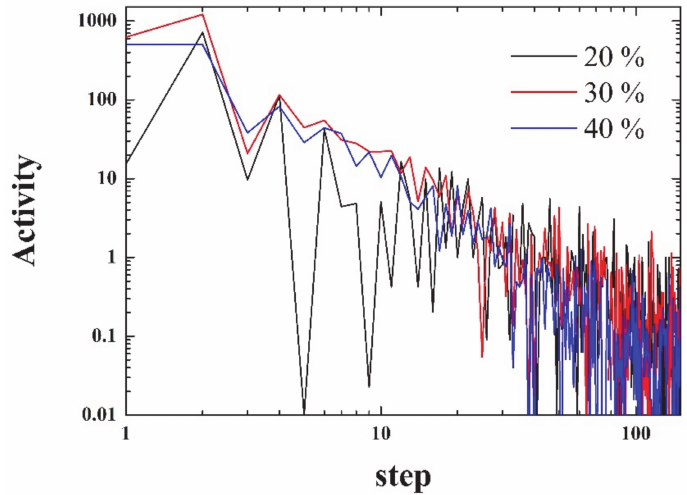
Figure 4. (Color online) Activity (as defined in Equation (1)) vs. timestep for three different initial densities (20, 30, and 40%), as labelled. Note the logarithmic scale on both